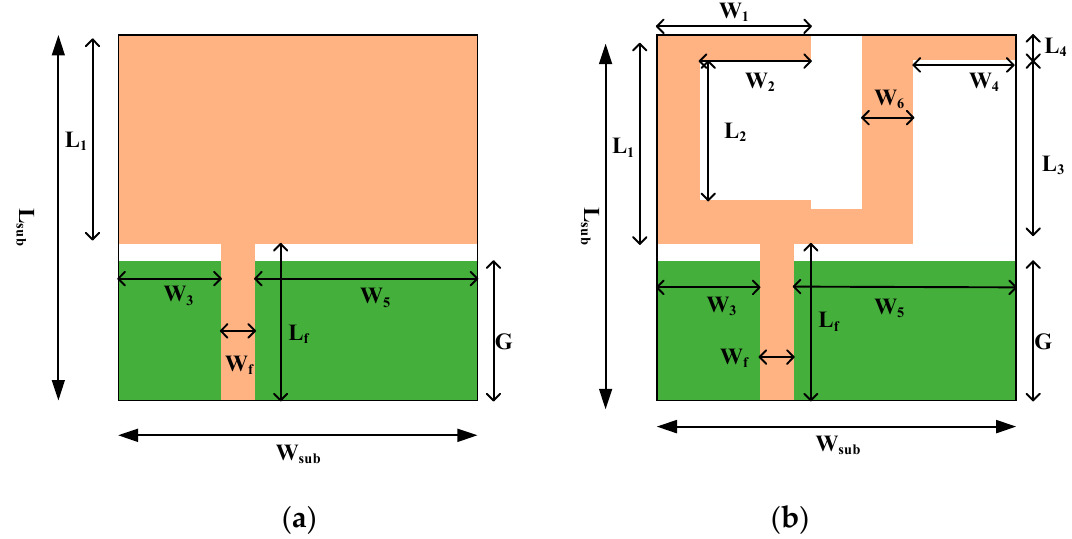
Figure 1. ( a ) Layout of simple RSMA ( b ) and optimized antenna design.